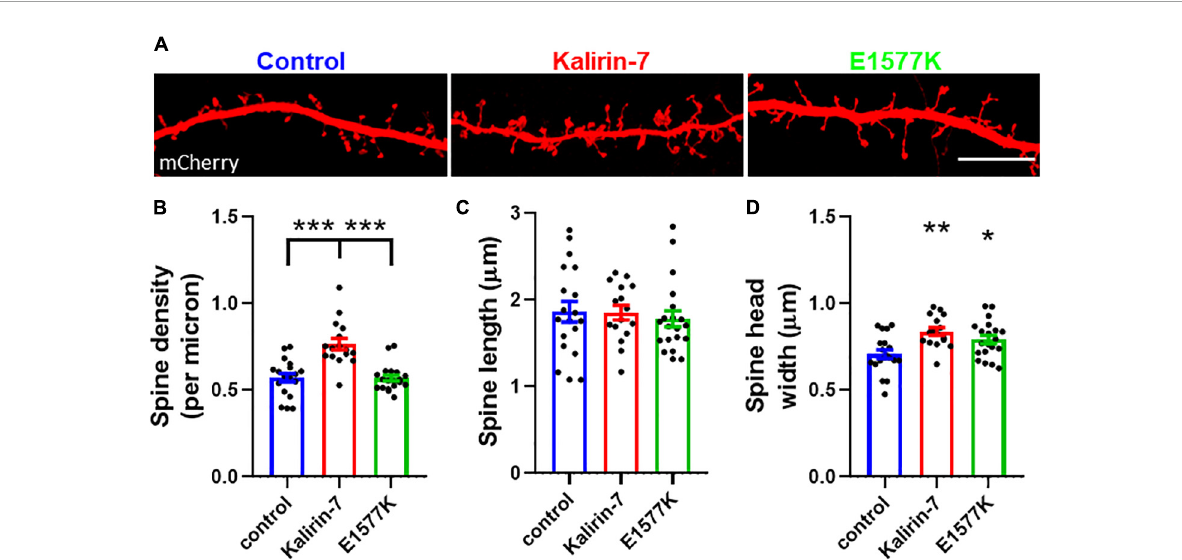
FIGURE3 E1577K fails to drive spine formation, but increases spine size. (A) Representative regions of mCherry labeled secondary dendrites. Scale bar = 10 µ m. (B) quantification of spine density per micron of secondary dendrite. Quantification of spine length (C) and head width (D) per neuron. Data points represent average ± SEM, * p < 0.05. ** p < 0.01. *** p < 0.005. n = 5–8 neurons per replicate, N = 3.